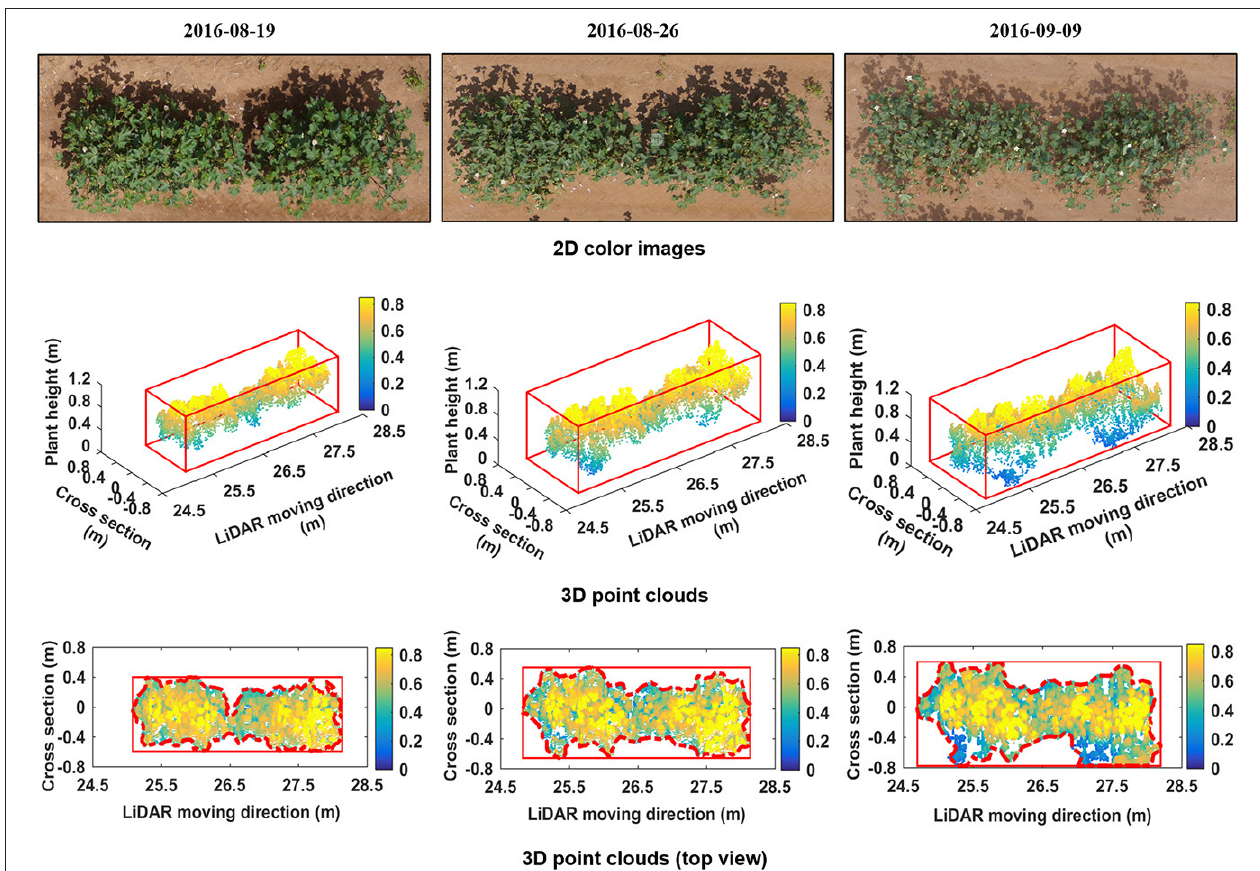
FIGURE 5 | Reconstructed 3D point cloud of one plot (Plot ID: row 8, column 6) and its evolution from August 19 to September 09, 2016. The first row shows 2D color images taken from above. The second row shows the reconstructed 3D point clouds of cotton plants. The third row shows height maps of cotton plants, obtained by projecting all points on the ground plane (color indicates